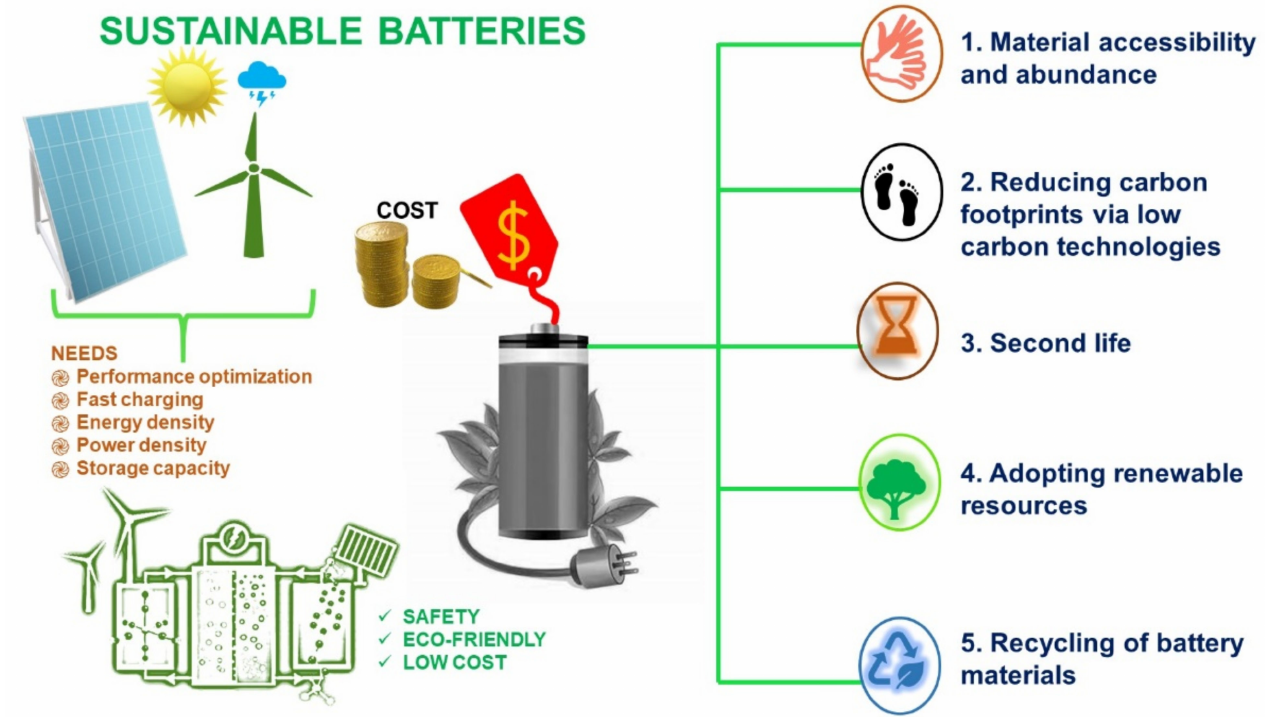
Figure 31. Approach needed for producing sustainable